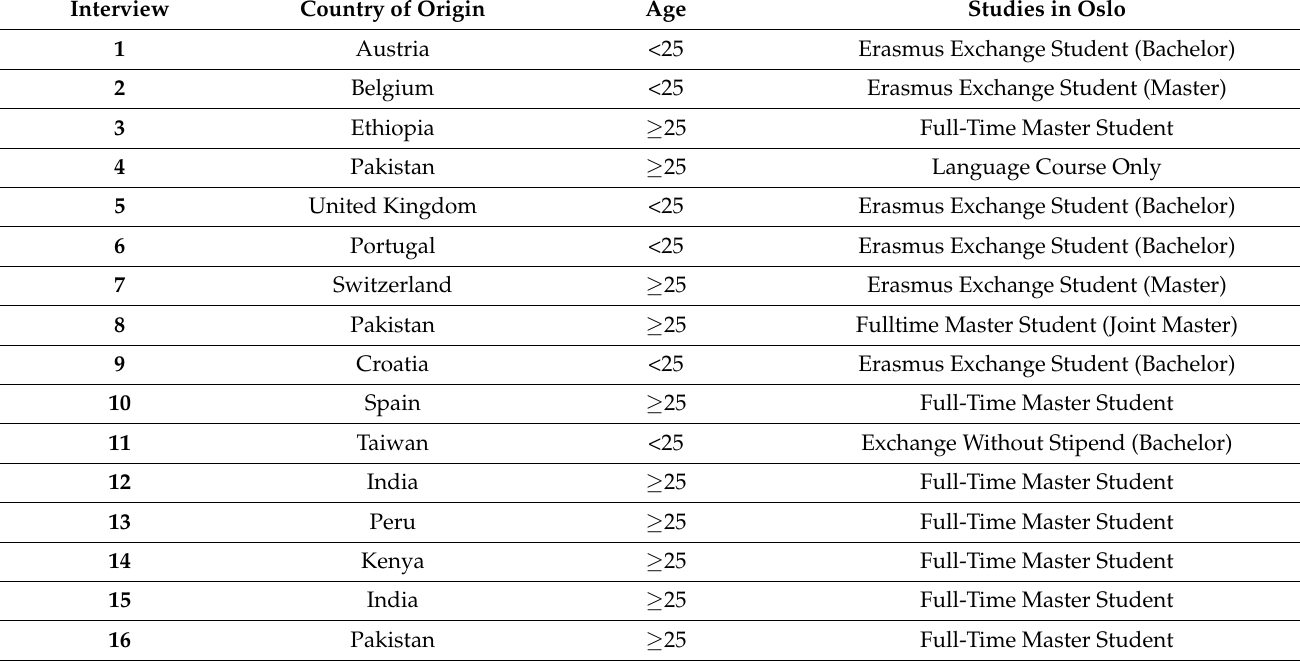
Table 1. Participants in the